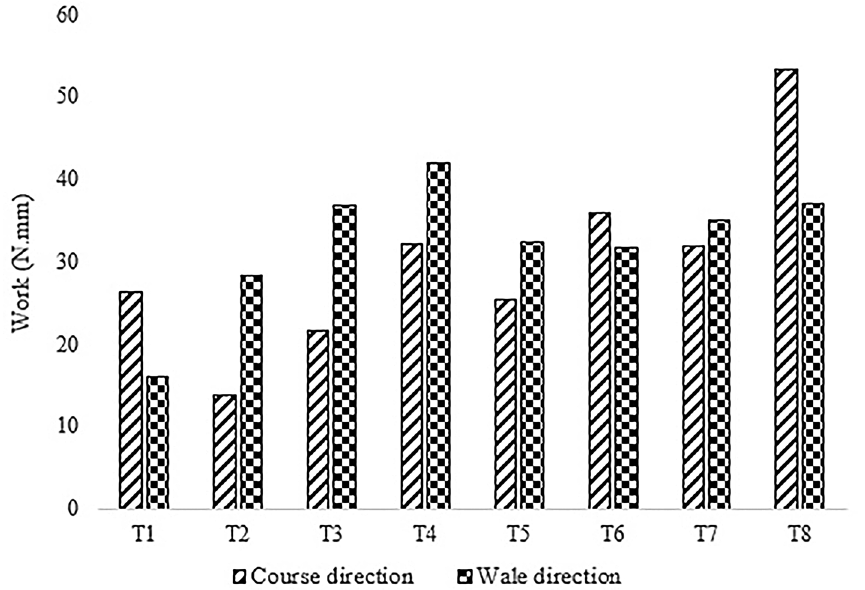
Fig. 4 Work values for pulling out of stitch yarn for all